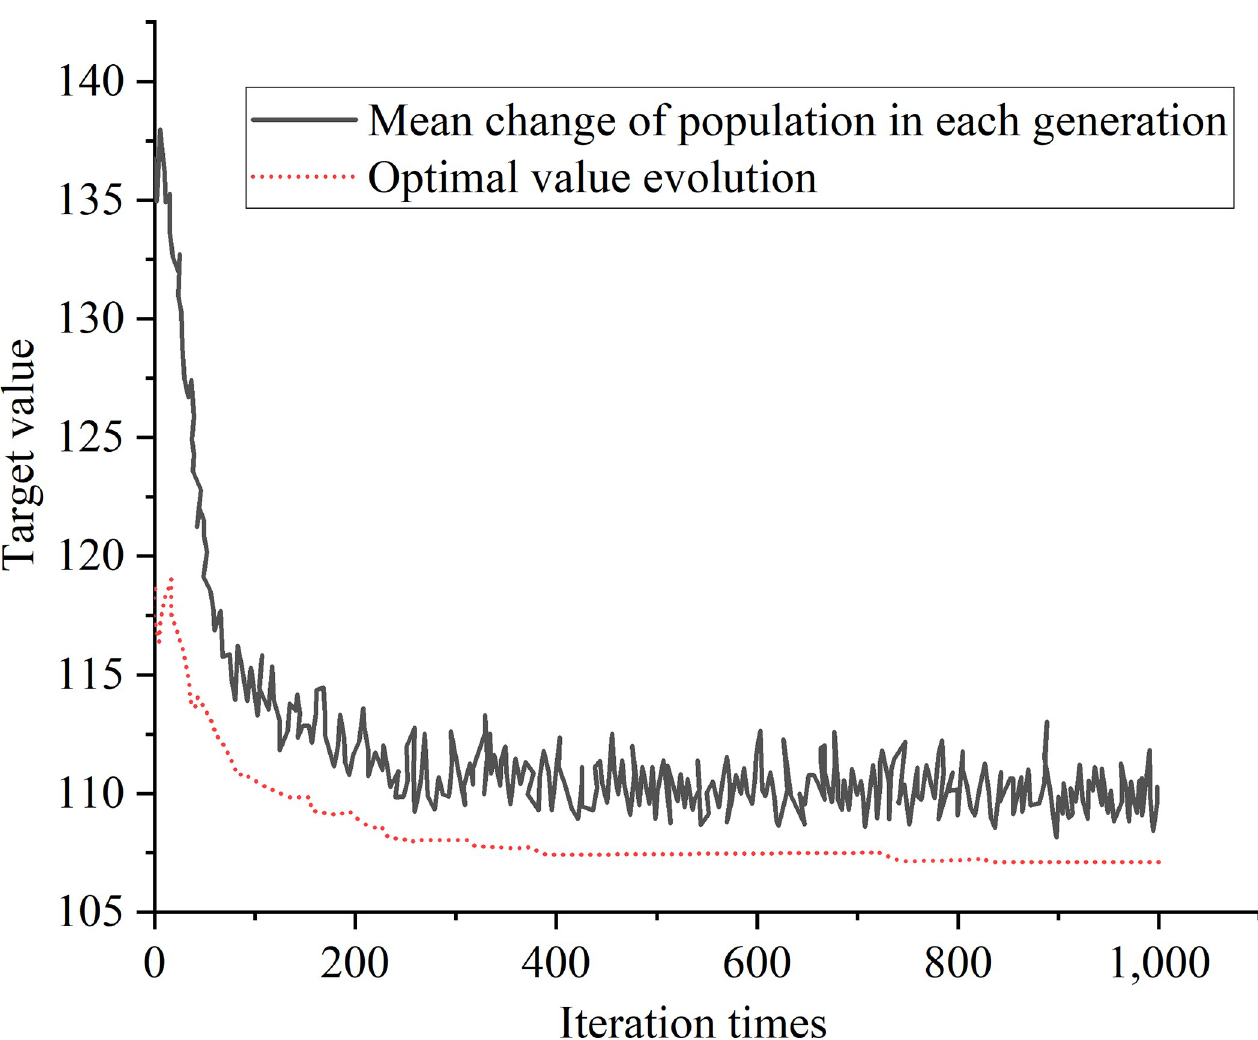
Fig 15. Simulation results of